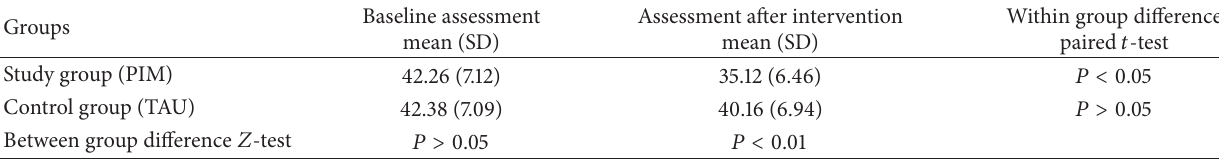
Table 3: State-Trait Anxiety Inventory before and after psychological intervention.